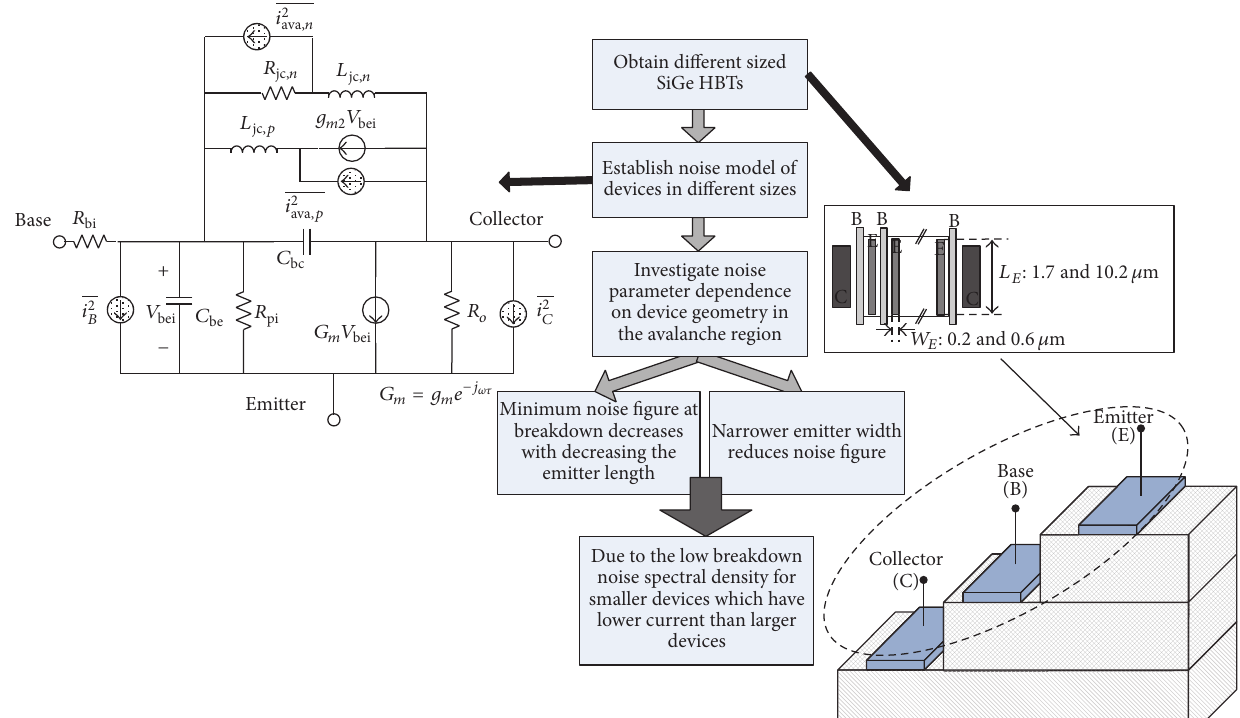
Figure 1: The flowchart of the presented analysis. The cross section of the SiGe HBTs with the diagram for different emitter lengths and emitter widths is also shown. The RF noise model including the inductive breakdown network is also presented. Although this noise model presented here for the sake of completeness is the same as [11], this work further extends to noise characterization for different sizes.